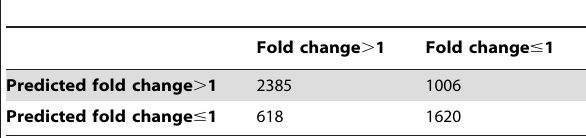
Figure 3. Support vector machine classifier effectively predicts fold change. Log-log plot of the eIF4E dataset fold change plotted with the corresponding support vector machine classifier results. The used eIF4E overexpression dataset consists of 4000 mRNAs for training and 5629 mRNAs for testing the classifier (see Materials and Methods). doi:10.1371/journal.pone.0004868.g003 Table 4. Confusion matrix of support vector machine for combination of total length with 3 9 UTR length and G + C content.